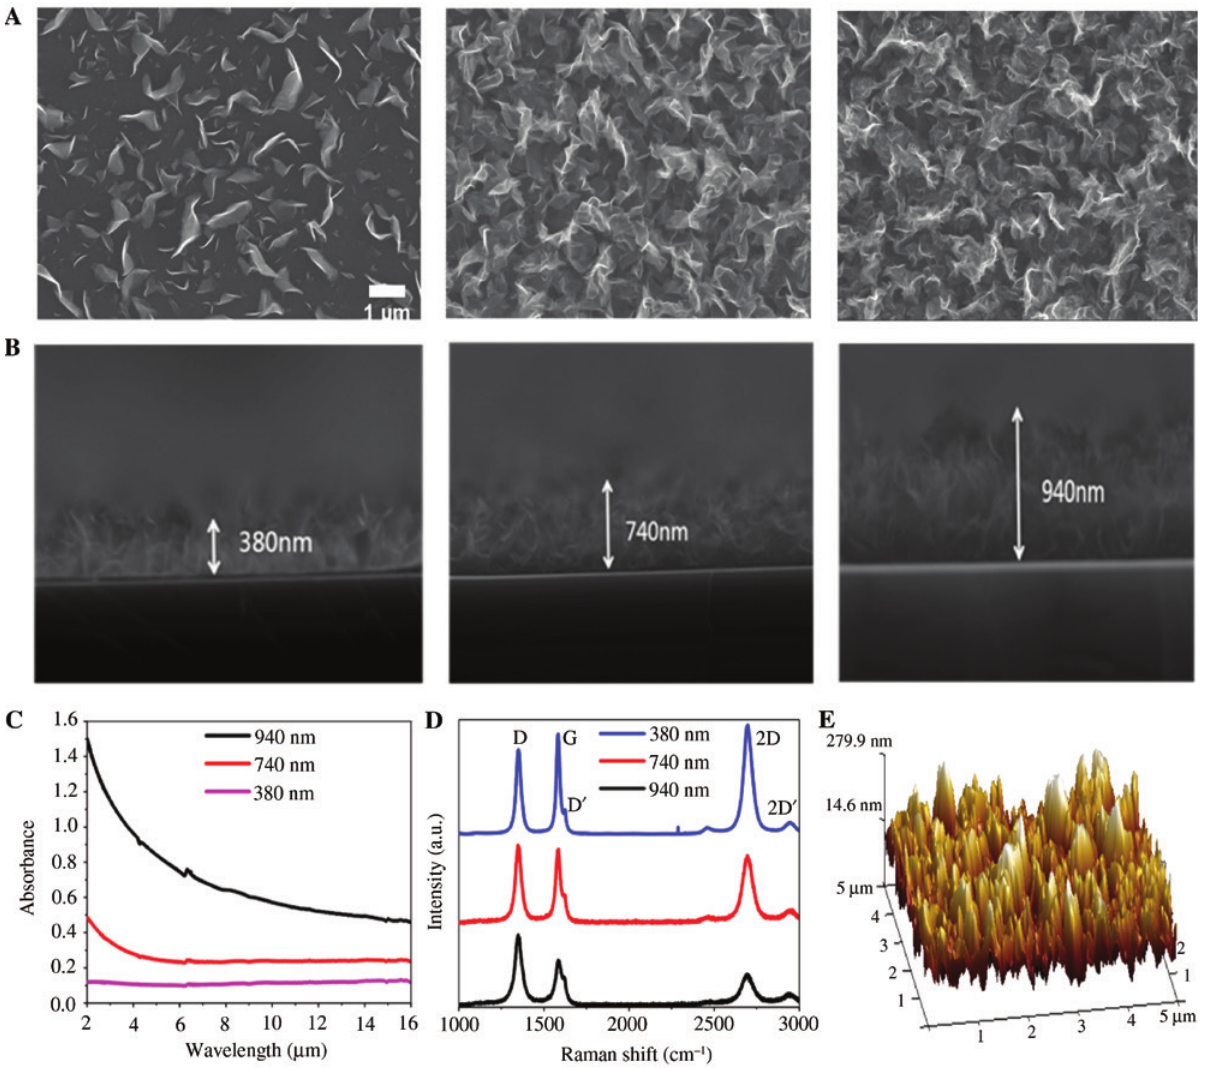
Figure 2: Morphology and optical characterization of the